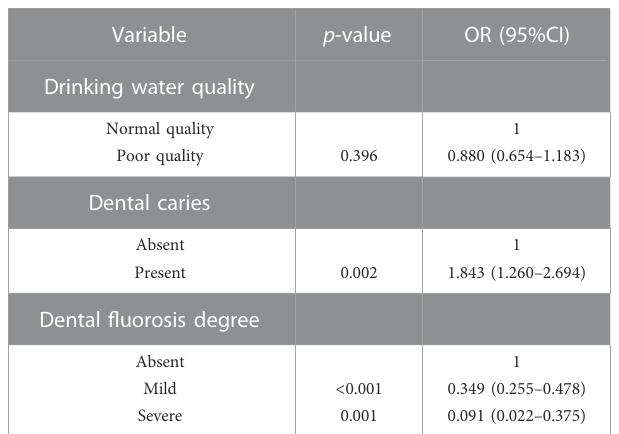
TABLE 4 Logistic regression analysis of the associations between the variable of interest and MIH.